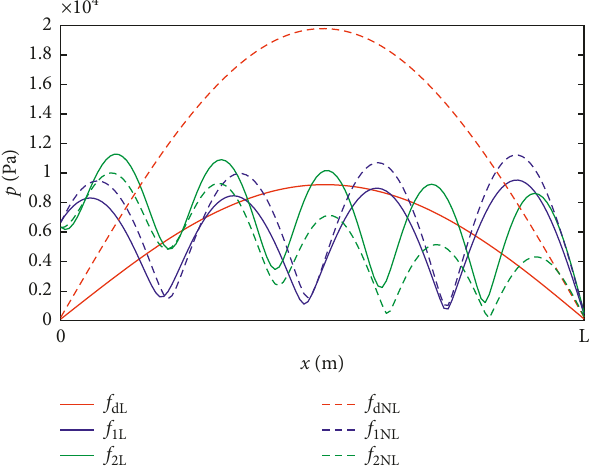
Figure 3: Pressure amplitude distribution of frequency compo- � p � 6 . 5 kPa: nents along the resonator in Case 1 at p 01 02 � 700 kHz, f � 900 kHz, f � 200 kHz (blue, green, and f 1L 2L dL � 700 kHz, red continuous lines, respectively) and f 1NL � 897 . 6 kHz, f � 197 . 6 kHz (blue, green, and red dashed f 2NL dNL lines,